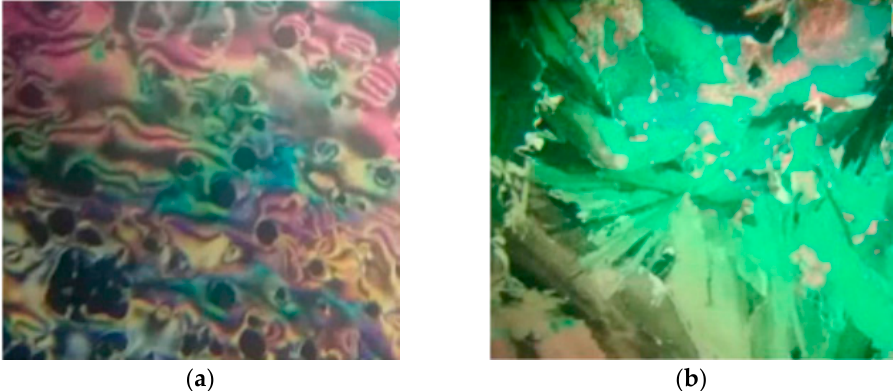
Figure 10. The optical photomicrograph for ( a ) the nematic phase of acid at 262.0 °C and ( b ) the smectic A phase of compound 7d at 120.0 °C. Reprinted/adapted with permission from Ref. [29]; published by MDPI AG, 2019.